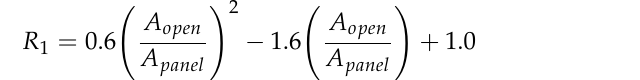
Table 8. Value for reduction factor R 2 by type of damage [166].